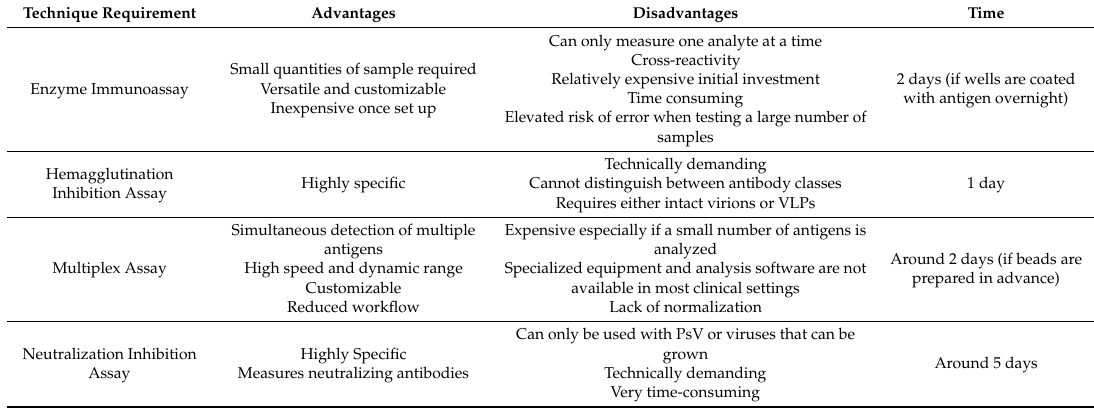
Table 1. Advantages and disadvantages of assay techniques for BK polyomavirus (BKPyV)